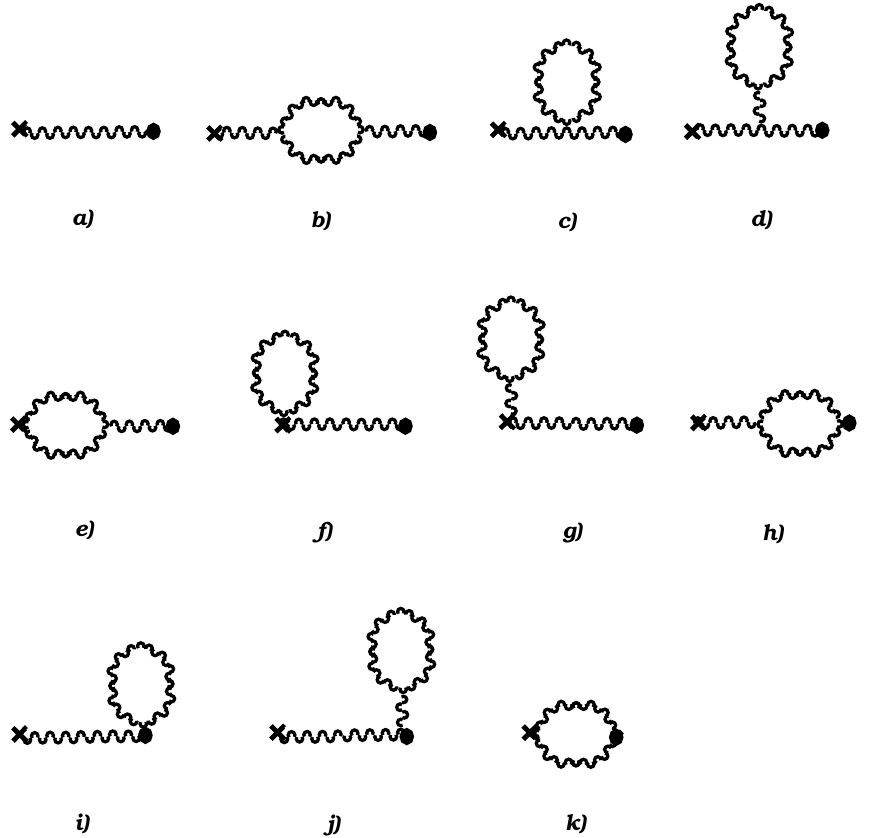
Figure 3 . One-loop diagrams for the averaged operator product h T zz ( z ) T zz (0) i . The points z and 0 are depicted by the cross and the dot,